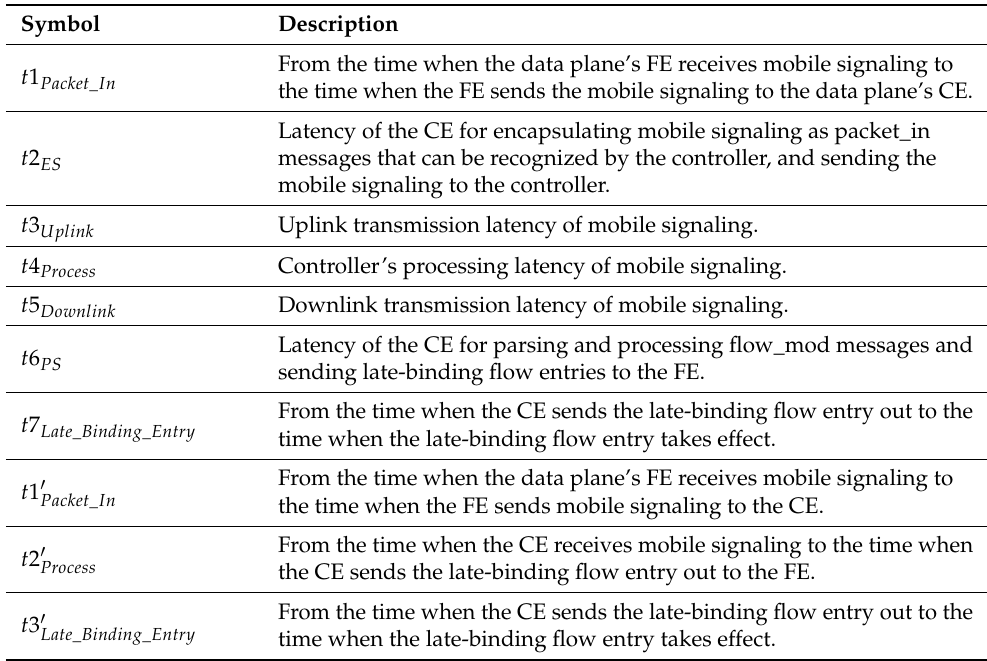
Table 1. Description of the symbols in Figure